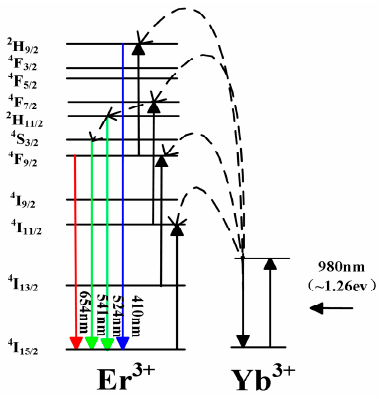
Figure 2. The detailed energy-level diagram and corresponding upconversion process of a hexagonal β -NaYF 4 :Yb 3+ , Er 3+ nanoparticle.